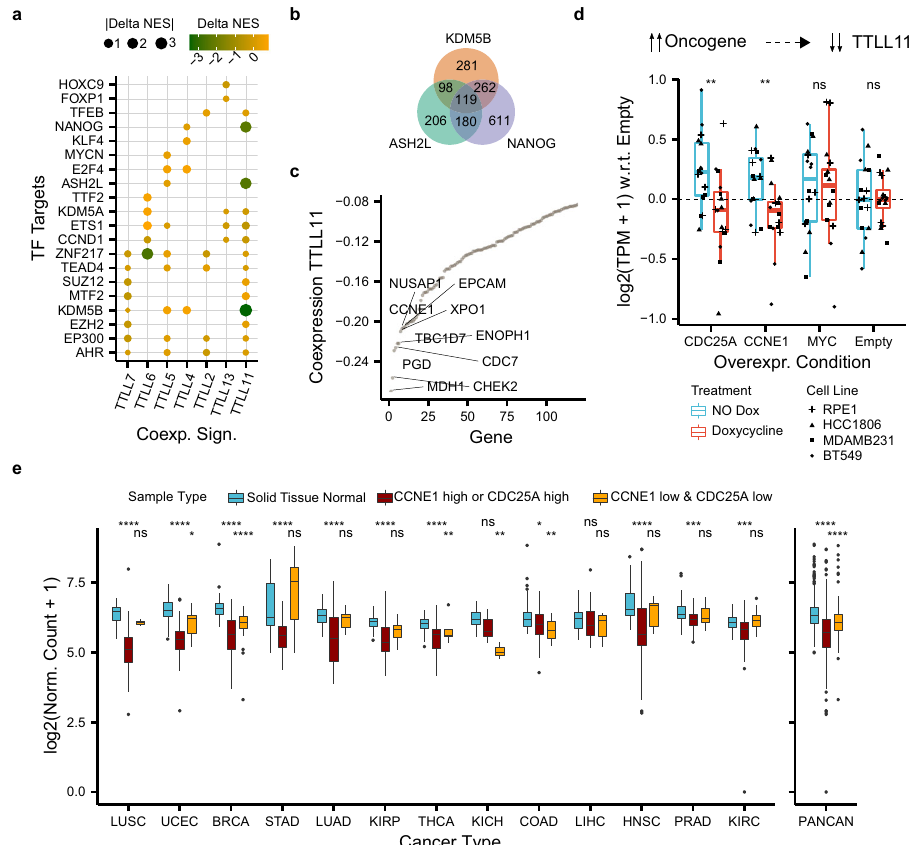
Fig. 6 | Co-expression-based analysis pinpoints the overexpression of onco- genesCCNE1orCDC25AasacausefortheconsistentdownregulationofTTLL11 across tumors. a Differences in normalized enrichment scores (NES) (Delta NES) between the tumor and healthy co-expression signatures ( x axis) of each TTLL glutamylase enzyme correlated against the rest of the genes. NES were obtained through gene-set enrichment analysis (GSEA) and show whether a co-expression pro fi le is signi fi cantly enriched (FDR<0.05) in genes targeted by a transcription factor ( y axis) from the ChIP-seq-based ChEA dataset 24 ). b Overlap between enri- ched transcription factor targets coexpressing with TTLL11 in tumors. c Co- expression( y axis)betweenTTLL11 and enriched 119transcriptionfactortargetsof KDM5B, ASH2L, and NANOG in tumors ( x axis). d Normalized gene expression of TTLL11 with respect to the control ( “ Empty ” ) condition ( y axis) upon over- expression with doxycycline ( “ Treatment ” color) of different oncogenes (x-axis) across four different cell models ( “ Cell Line ” dot shape). Each condition and treatment contain N =16 biologically independent experiments (four for each cancercellline).In eachboxplot, the medianvalue isindicatedasahorizontalline and the lower and upper bounds of the box correspond to the fi rst and third